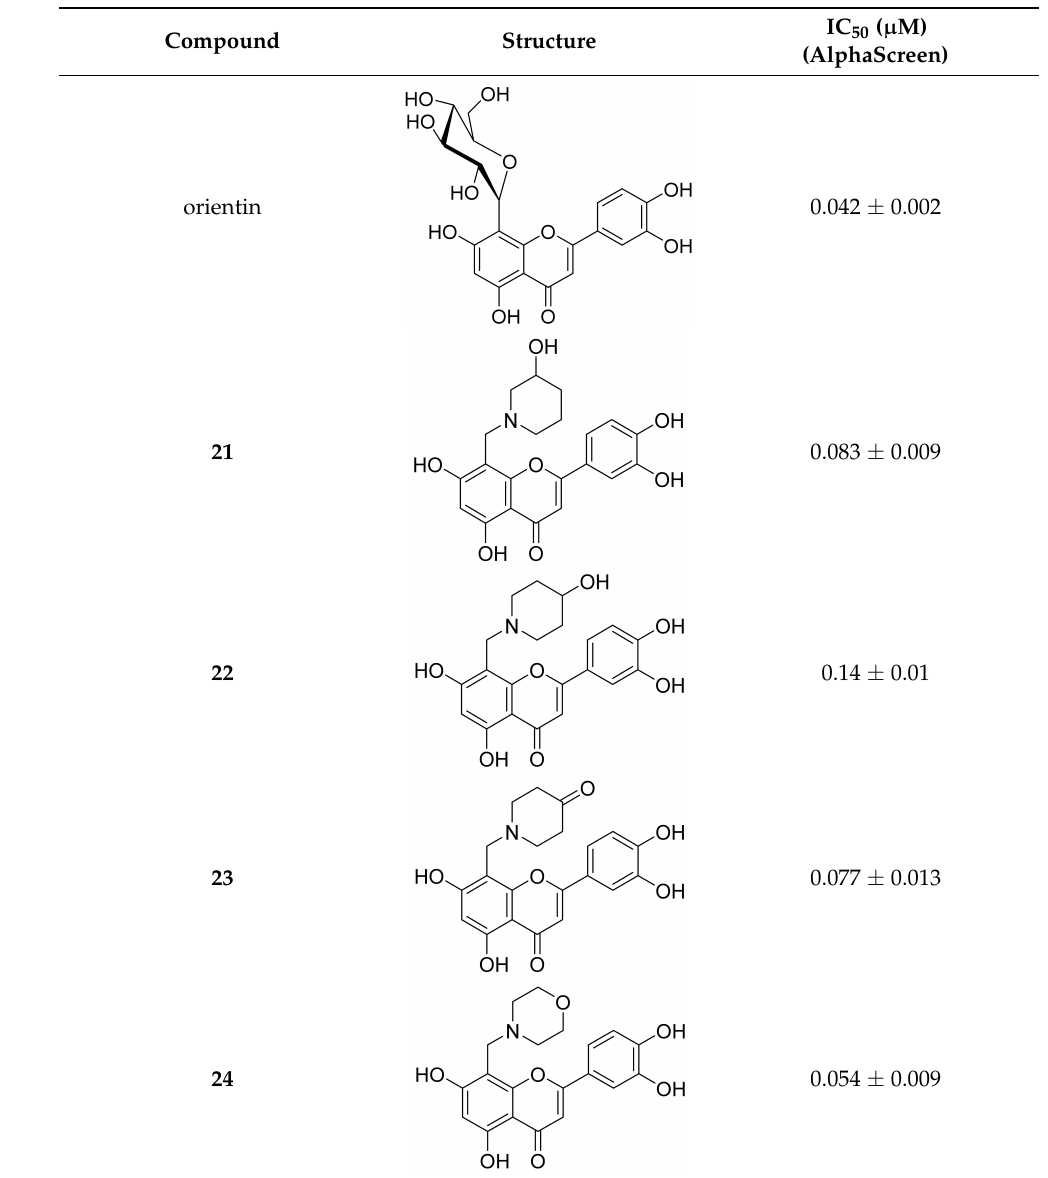
Table 2. Inhibition assay of influenza endonuclease. Structure–activity relationship of C-8 luteolin